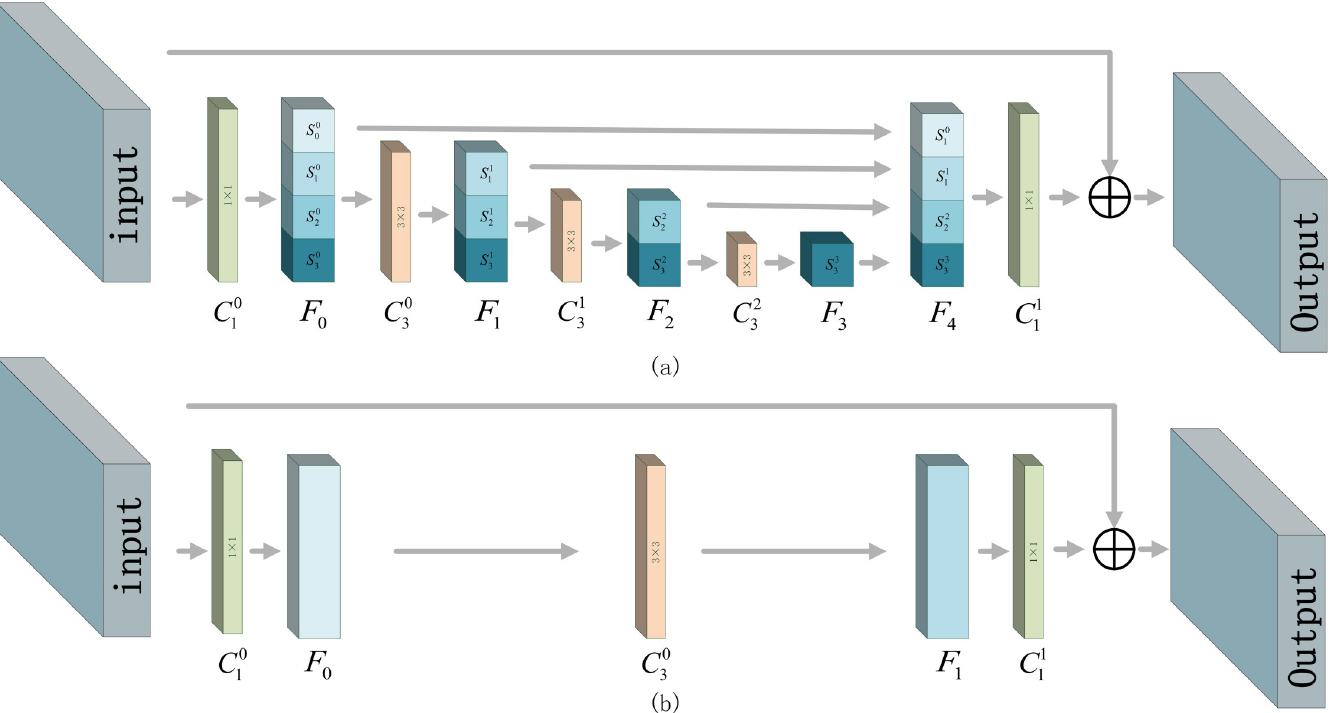
Fig 2. Comparison between stepwise res-block and res-block, (a) is stepwise res-block, (b) is res-block.